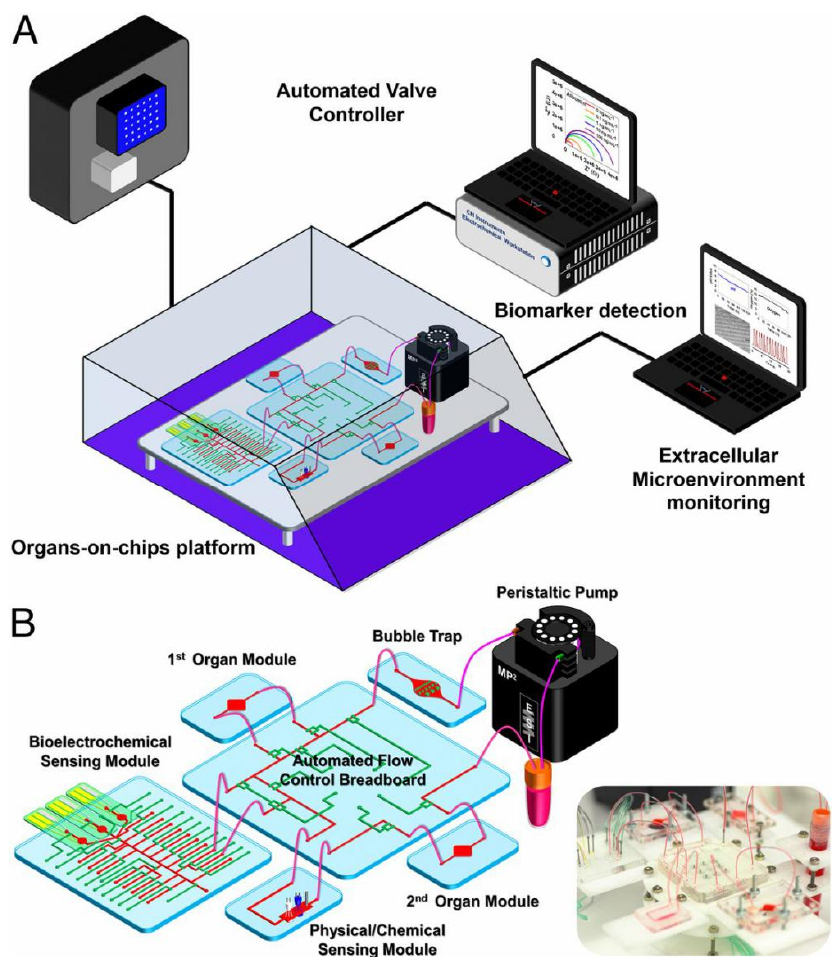
Figure 6. Integrated automated multiorgan-on-a-chip and sensing platform. ( A ) Schematic of a full